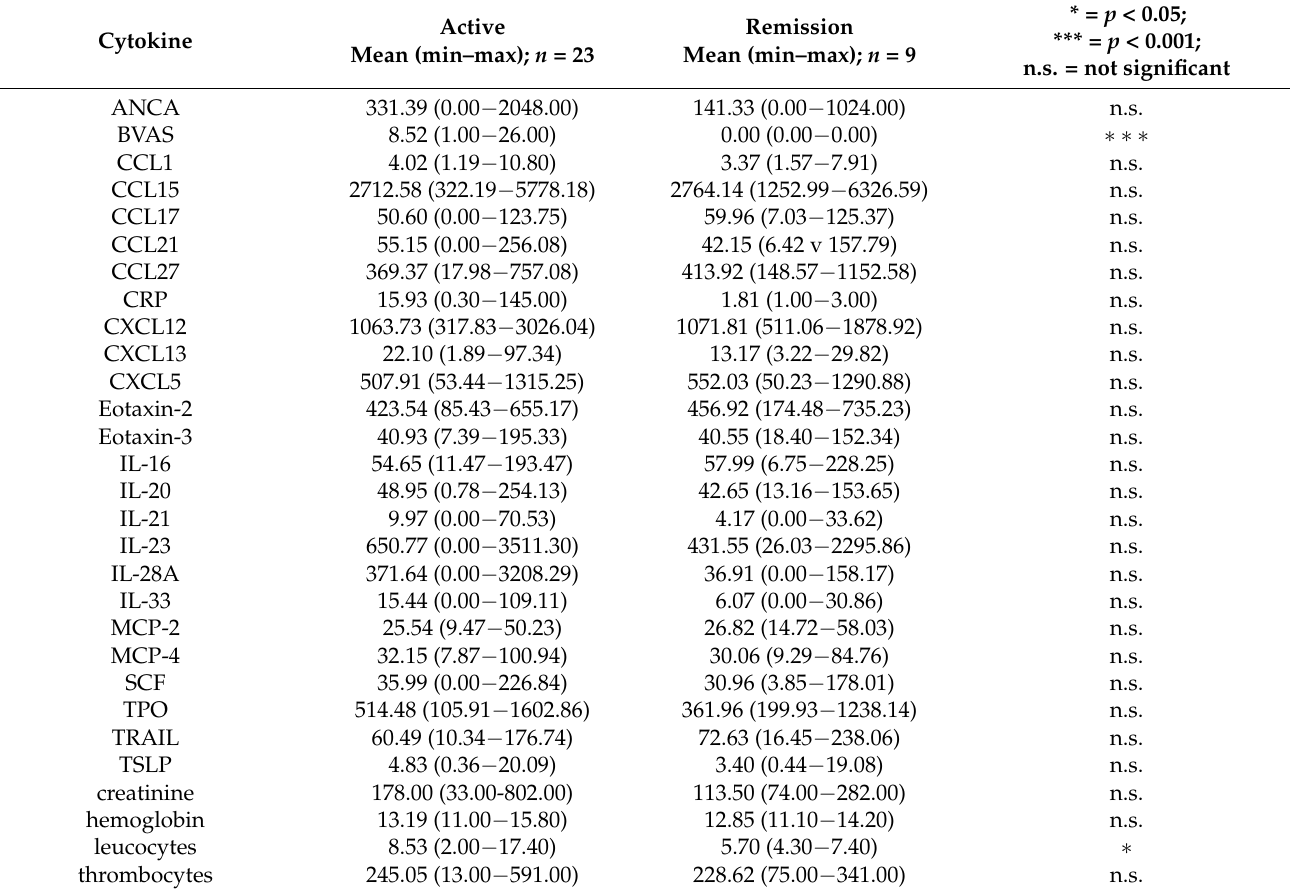
Table 2. Summary of all tested cytokines, laboratory parameter, PR3-ANCA titer, and BVAS in active AAV and in remission. Active Cytokine Mean (min–max); n = 23